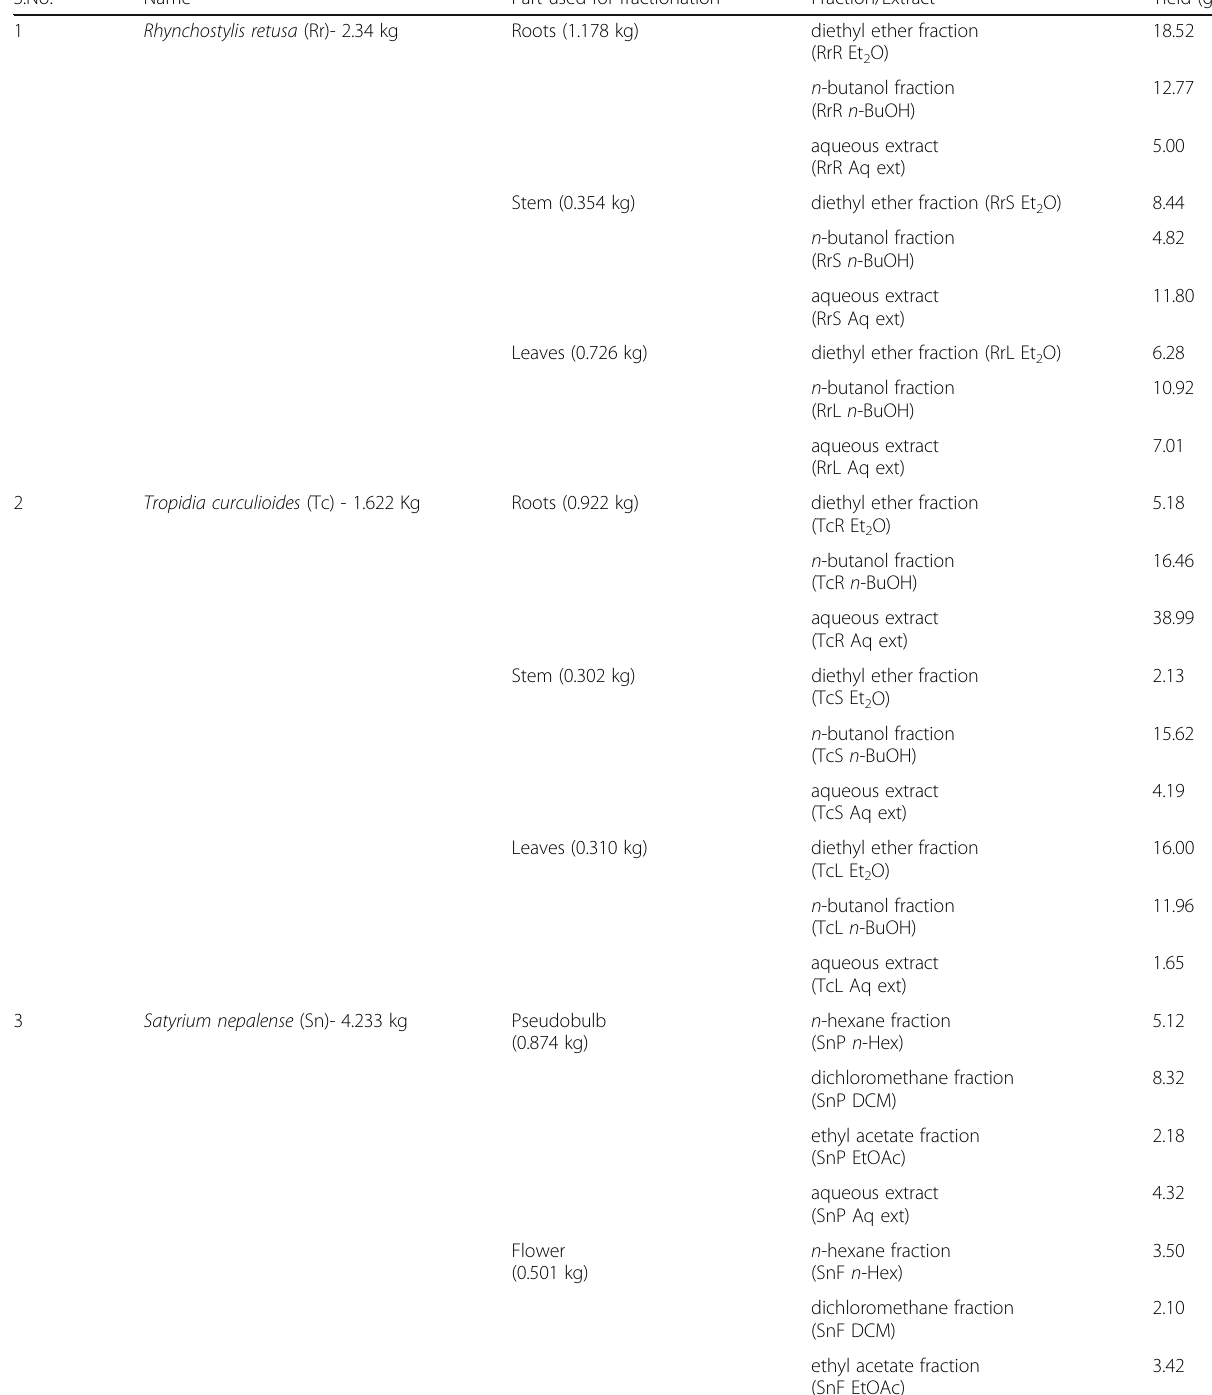
Table 2 Details of extraction and fractionation of medicinal orchids obtained from AR